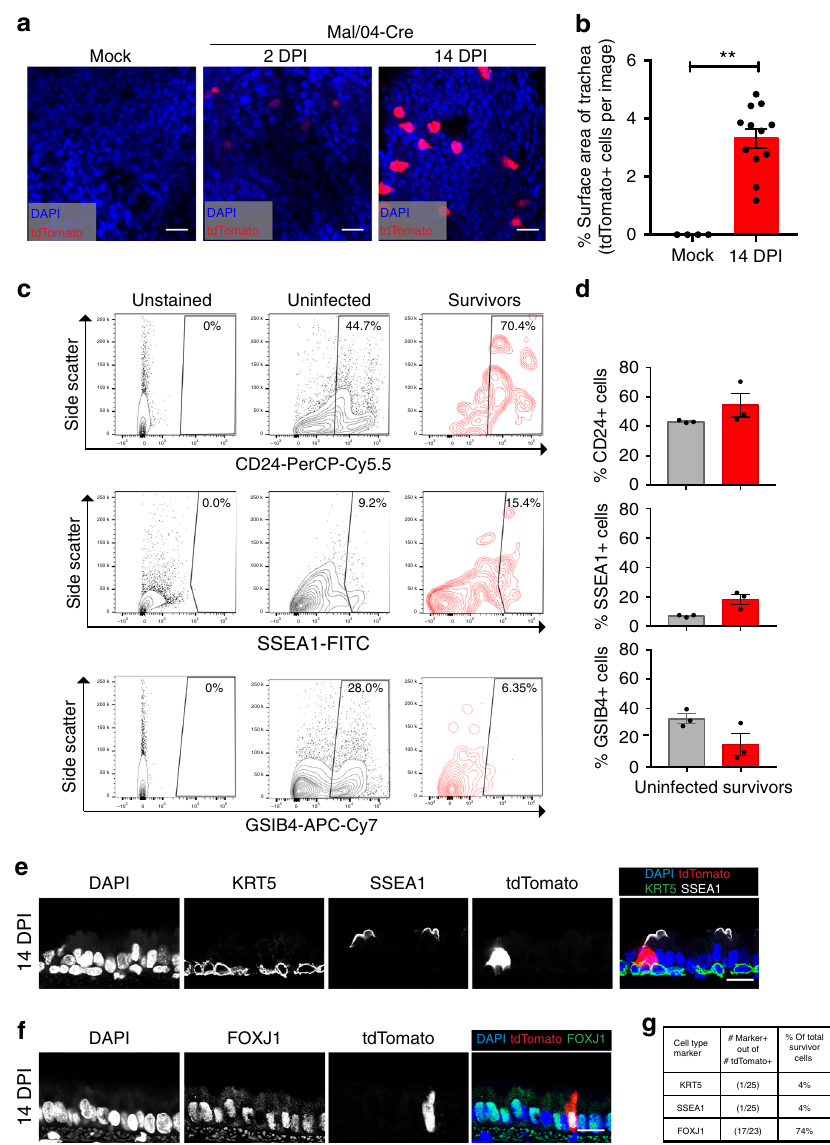
Fig. 3 IBV survivor cell populations are predominantly composed of cells expressing ciliated cell markers. a Tracheas were collected from Mock and Mal/ 04-Cre infected mice at 2 and 14 DPI then opened longitudinally and fl attened to image the surface area of the whole-mount tracheal epithelium. Scale bar = 25 μ m. b Quanti fi cation of apical surface area covered by tdTomato + survivor cells from whole-mount trachea images. n = 4, 12 images per group, respectively, Student ’ s T -test. c Flow cytometry of 14 DPI tdTomato- (uninfected cells) and 14 DPI tdTomato + (survivor cells) from the lungs of Mal/04- Cre infected mice, where cells are stained with CD24 (ciliated), SSEA-1 (secretory), GSIB4 (basal) cell surface markers. d Quanti fi cation of fl ow cytometry. n = 3 mice per group. e Cross-sectioned microscopy of murine tracheal epithelial cells from mice 14 days post-infection with Mal/04-Cre stained with KRT5 to label basal stem cells and SSEA-1 to label secretory cells. f Cross-sectioned microscopy of murine tracheal epithelial cells from mice 14 days post- infection with Mal/04-Cre stained with FOXJ1 to label ciliated cells. g Quanti fi cation of tdTomato + survivor cells stained with cell-speci fi c markers: KRT5, SSEA-1, and FOXJ1 compiled from two independent experiments. Data are presented as the number of marker + cells out of total tdTomato + cells and the percentage was calculated for marker + cells out of total tdTomato + cells imaged. S.E.M was plotted to indicate variability around the mean for tested samples, * p ≤ 0.05, ** p ≤ 0.001, ns not signi fi